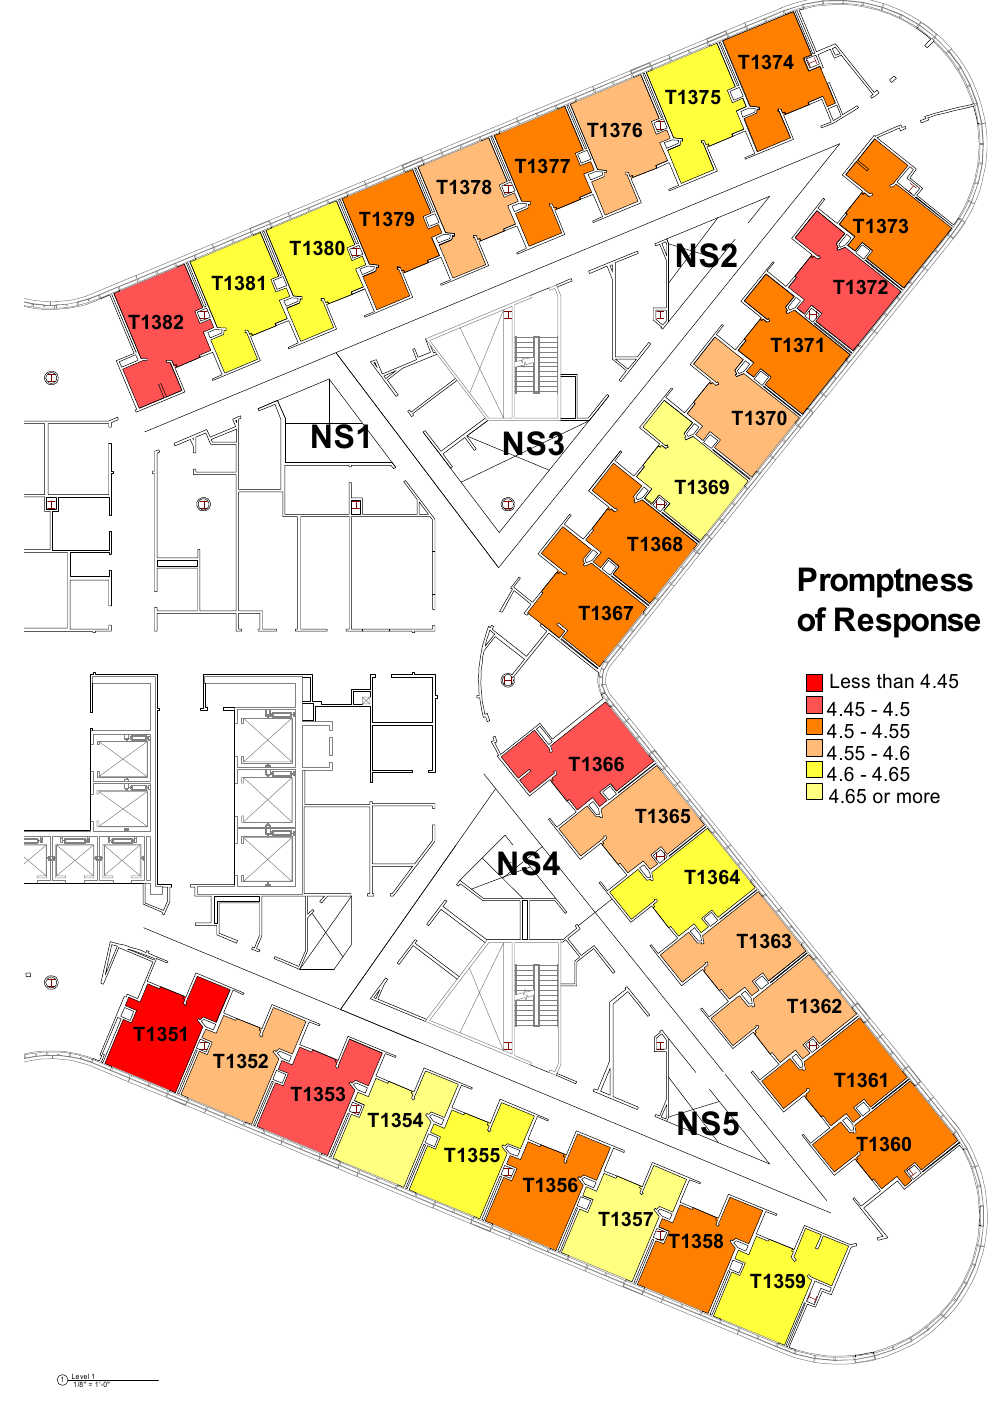
Figure 3. Heat map of room-level patients’ perception of staff’s “promptness in responding to call button” based on Press Ganey survey.